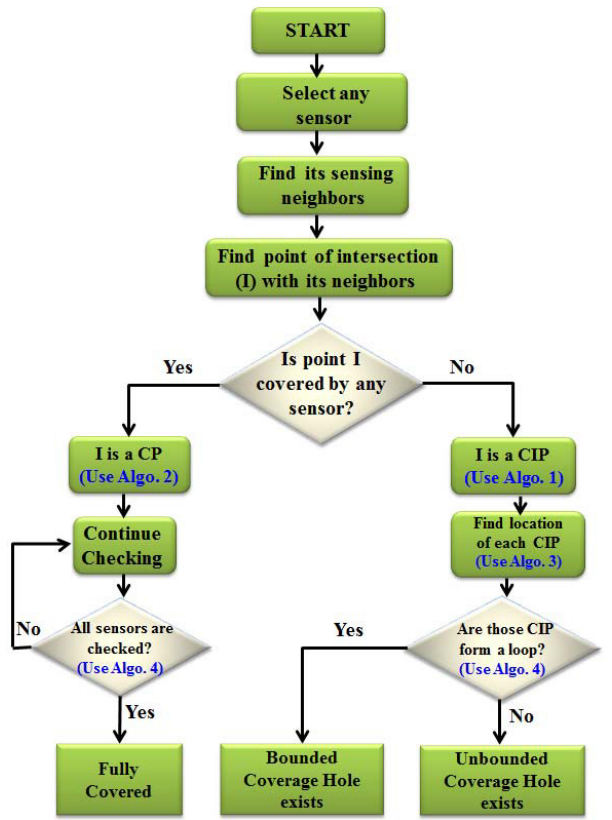
Figure 5. Flow chart of the complete coverage hole detection